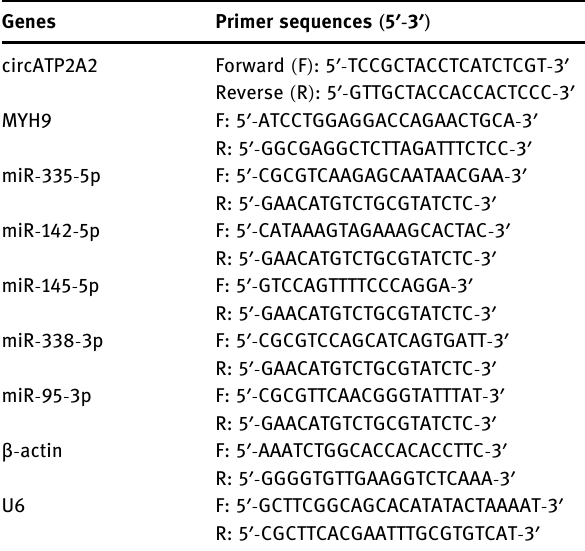
Table 2: Primer sequences utilized for RT - qPCR Genes Primer sequences ( 5 ′ - 3 ′ )